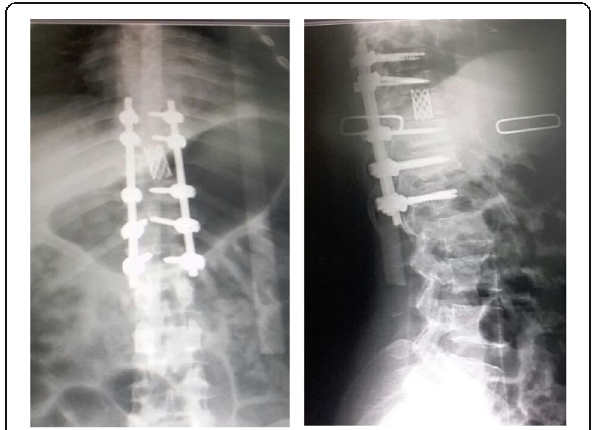
Fig. 9 Postoperative X-ray AP and lateral after decompression with pyramesh cage reconstruction (case